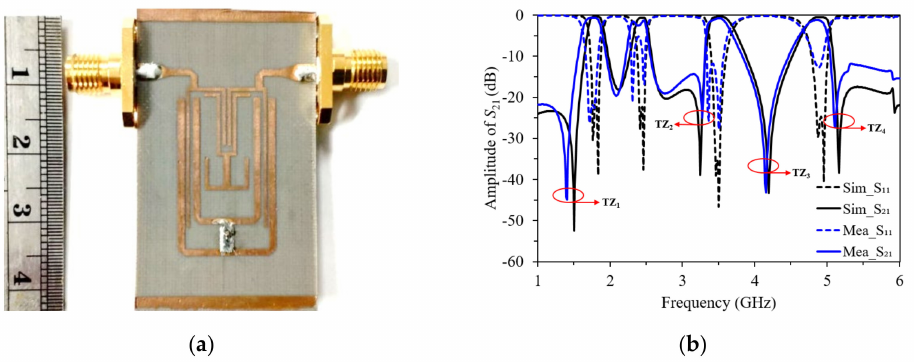
Figure 7. ( a ) The photograph of the proposed quad-band BPF; ( b ) simulated and measured results of the quad-band BPF. Table 2. Comparison between the proposed quad-band BPF and other reported